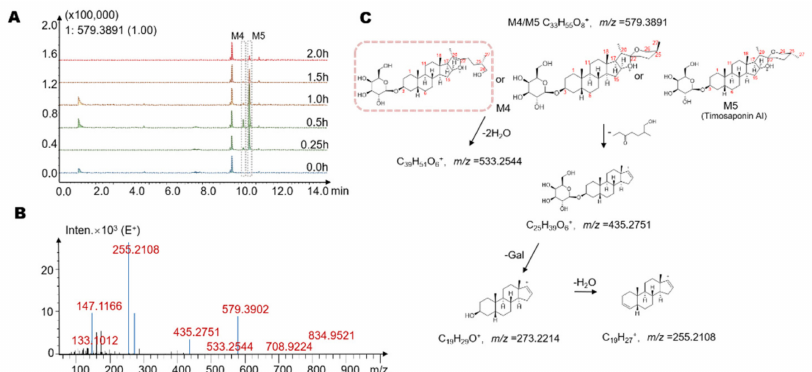
Figure 4. ( A ) The extracted ion chromatograms (EICs) showed that the levels of the possible metabo- lites M4 and M5 increased with increasing time. ( B ) The MS/MS data of the timosaponin BII metabo- lites M4 and M5. ( C ) Possible structures and mass spectrometric cleavage pathway of metabolites M4 and M5. Among them, the structure framed by a rectangle was reported in the gut microbiota for the first time.